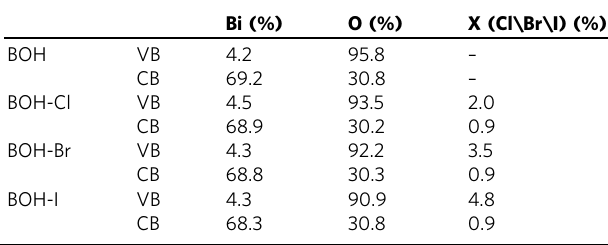
Table 1 The contributions of Bi, O, and X (X = Cl, Br, I) to the near band edges. Bi (%) O (%) X (Cl\Br\I) (%) BOH VB 95.8 – – BOH-Cl